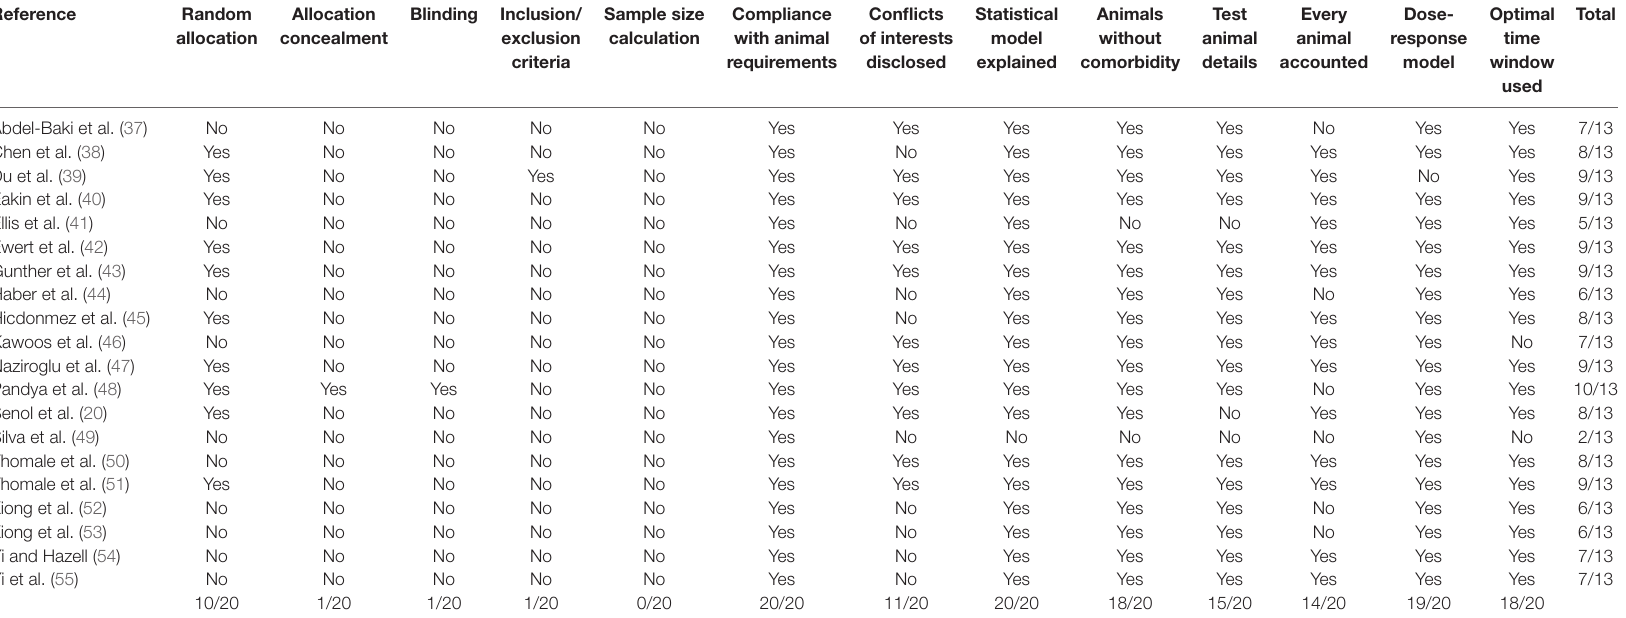
allocation allocation concealment